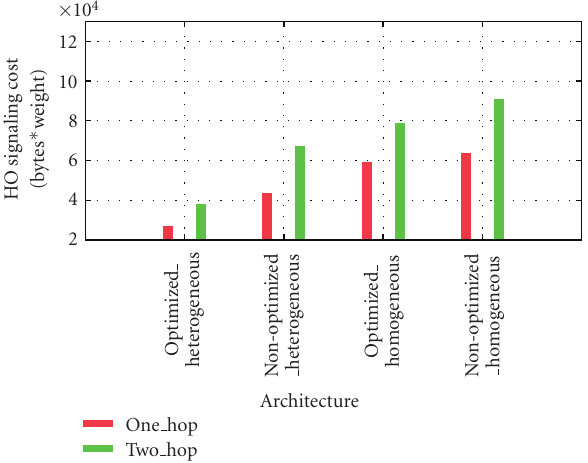
Figure 17: Neighborhood definition e ff ect on HO signaling